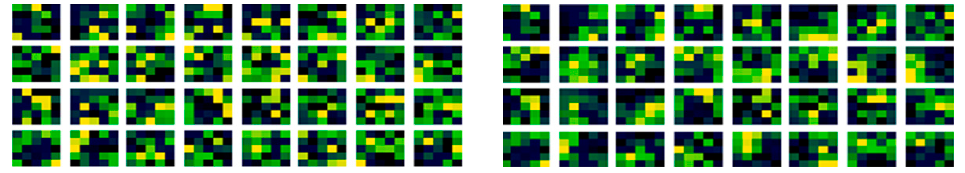
Figure 4. Initial and learned weights in the first conv layer with the existing random method.